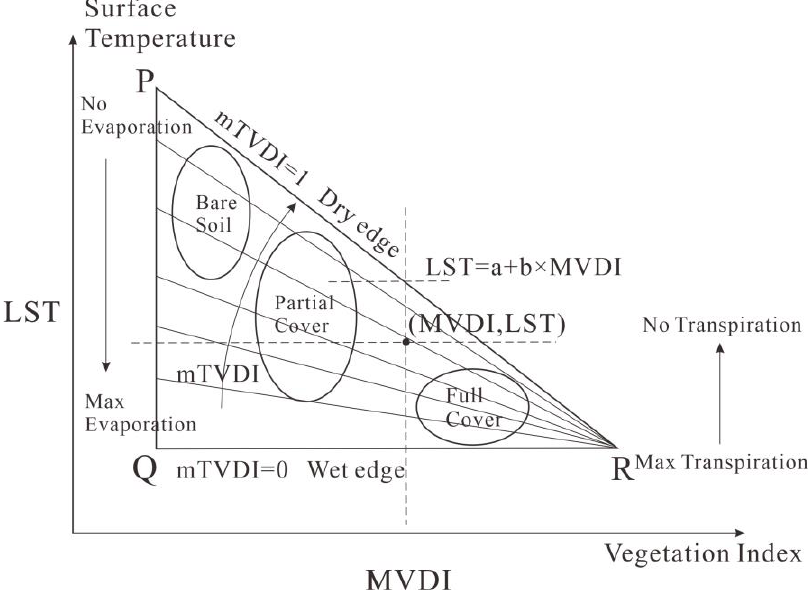
Figure 6. The MVDI–LST triangle space and definition of the mTVDI. In this study, LST was extracted by using 0.01 as the interval of the MVDI, and a 95% confidence interval was selected to leave out possible abnormal LST. Then, a series of maximum and minimum LSTs corresponding to the MVDI were calculated. After that, the dry and wet edges of the mTVDI were extracted using the linear regression method. The performance evaluation of the mTVDI is discussed in the Results and Discussion sections.